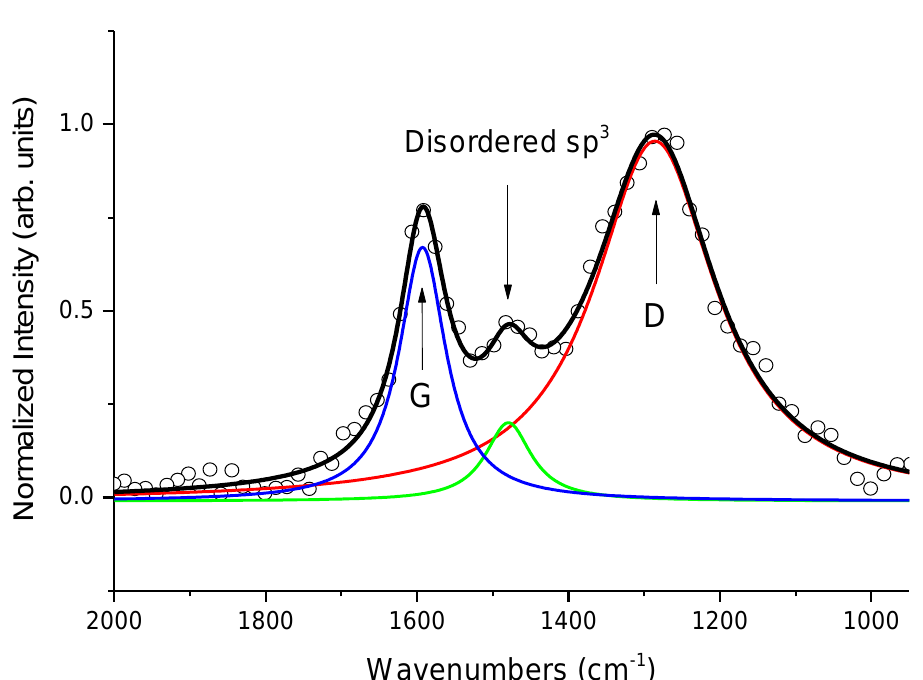
Figure 2. Simulated D (red), G (blue), and disordered sp 3 (green) bands in Amorphous Carbon detected in clay samples from Khirbat Iskandar. Ratio between areas and intensities of D and G bands were used to determine production parameters of clay. (Reproduced from work in [25] with the permission of Elsevier, copyright 2018.).